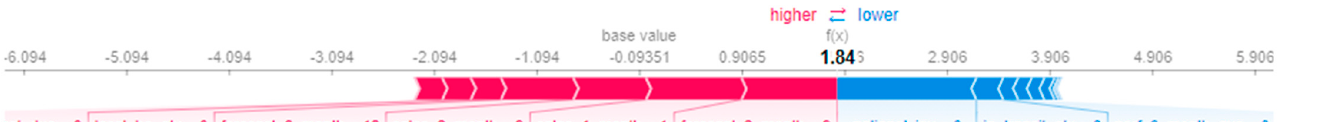
Figure 9. Product correctly classified as